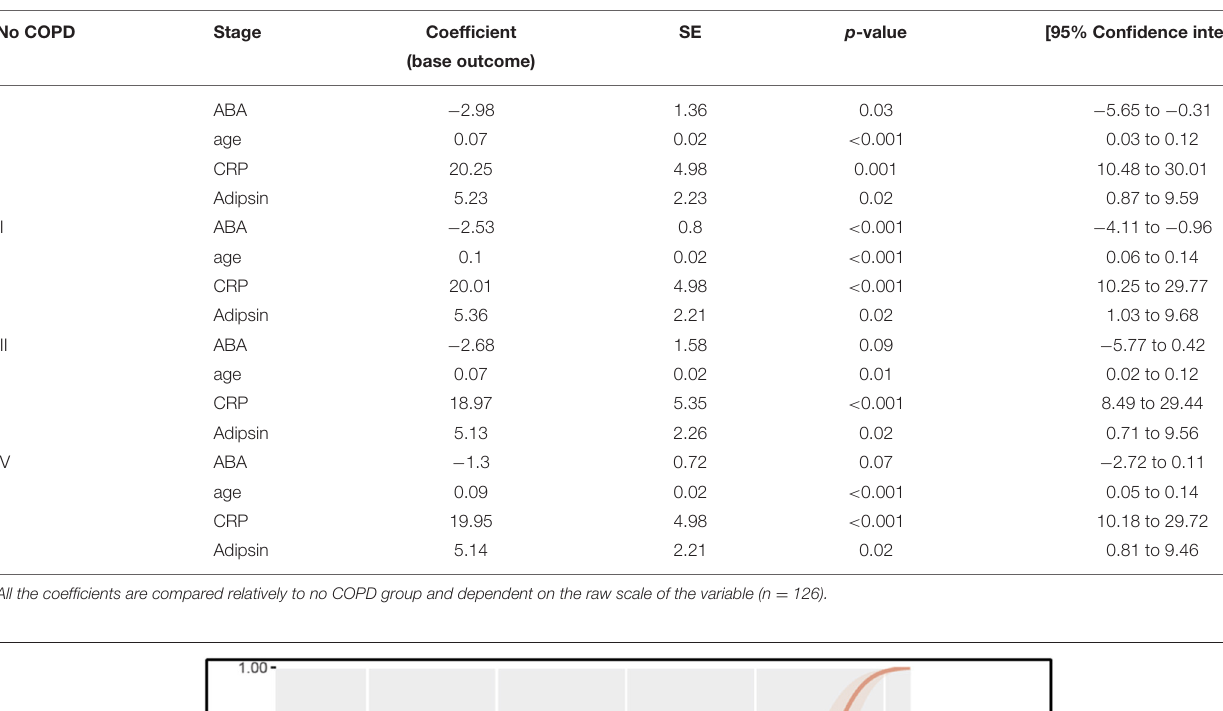
TABLE 3 | Multinomial logistic regression model.